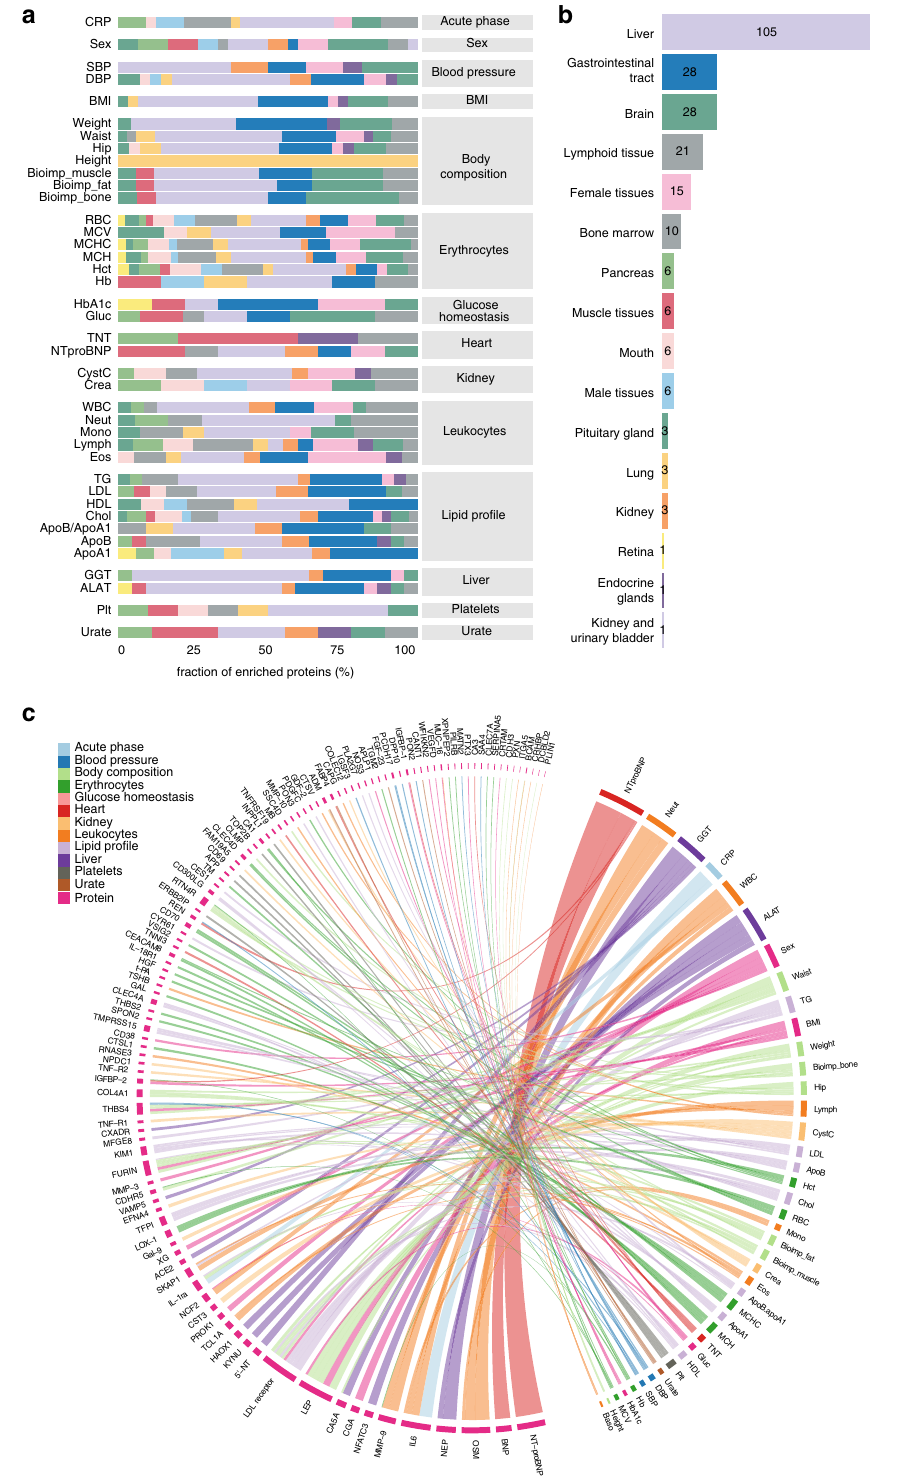
Fig. 6 Tissue enrichment analysis of the blood proteome retrieved from mixed-effect modeling. Distribution of tissue enriched proteins in ( a ) each of the clinical parameters classi fi ed based on the tissue type and protein pro fi ling results and using the color code in ( b ), with a bar plot showing the distribution of the number of tissue enriched proteins for each tissue type. c Chord diagram of the top fi ve most associated proteins for each of the clinical parameters, colored by clinical variable class. The ribbon thickness is proportional to the -log adjusted